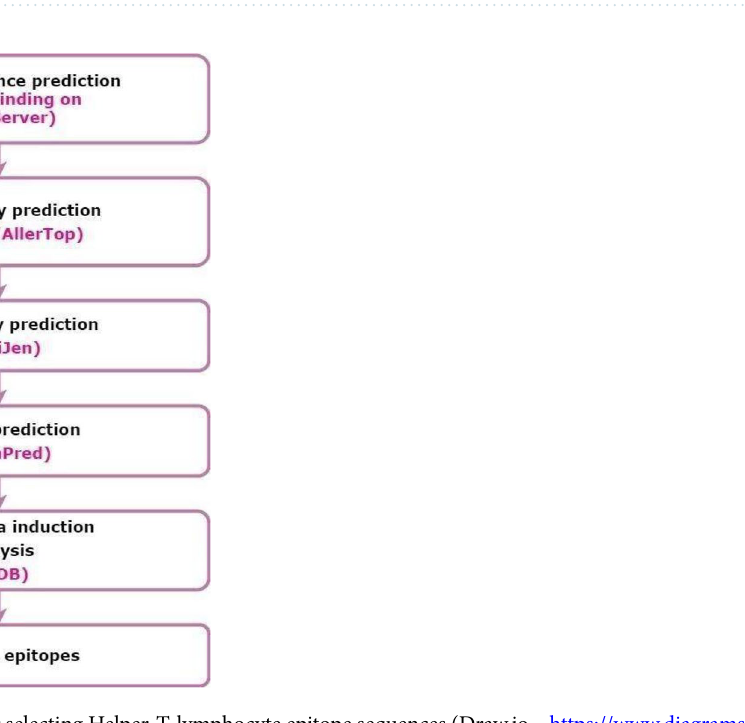
Figure 5. Workflow for selecting Helper-T-lymphocyte epitope sequences (Draw.io—https:// www. diagr ams. net/- 14.6.